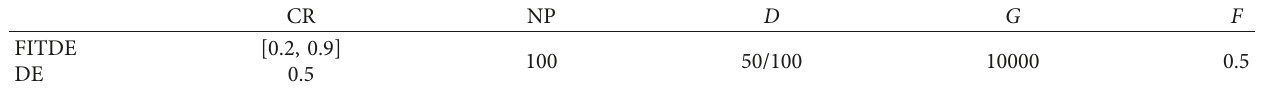
Table 2: Parameters in the